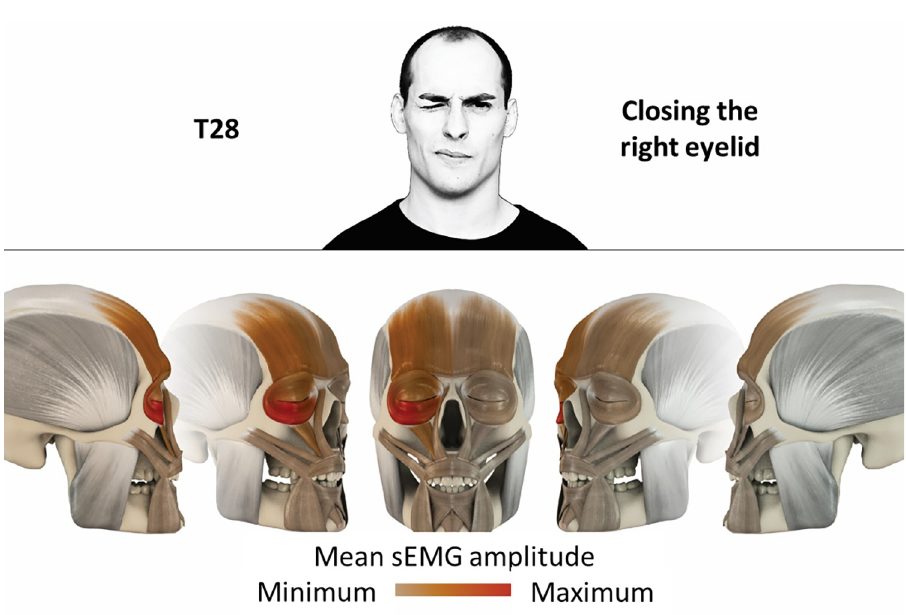
Fig 29. Color-coded facial muscle activation pattern of task T28. Closing the right eyelid. Animation by Jonas Laustro¨er.